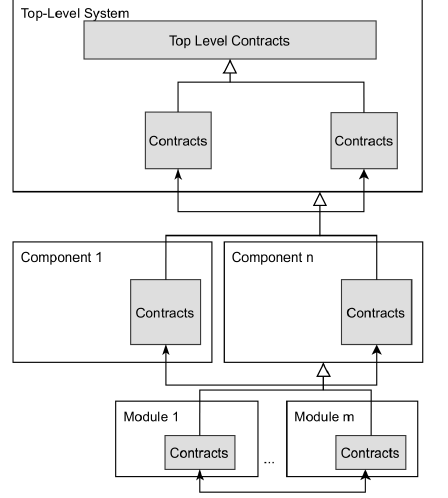
Figure 6. Compositional Verification based on a Virtual Integration Test.